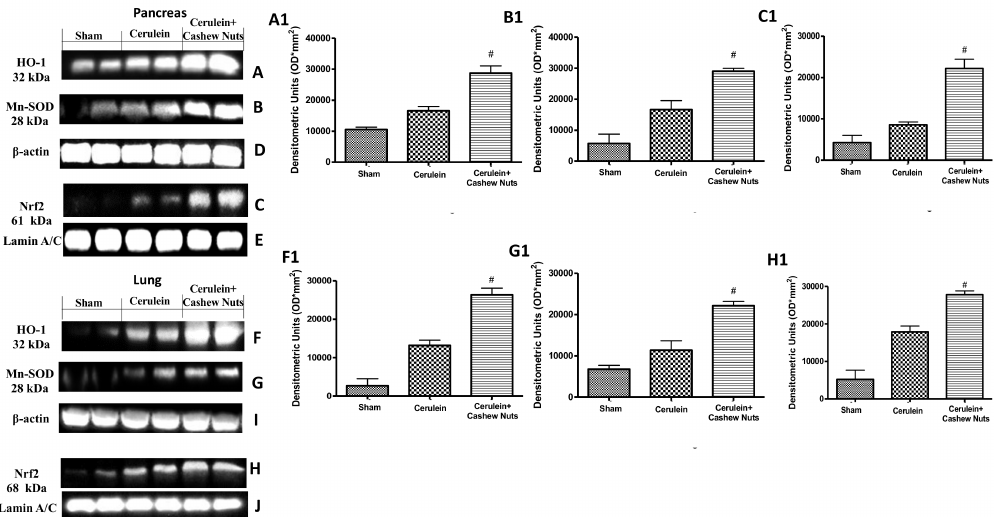
Figure 4. E ff ects of cashew nuts on the nuclear factor E2-related factor 2 (Nrf2) pathway in cerulein-induced AP as assessed by Western blotting. Pancreatic Western blots of HO-1 ( A ), manganese-dependent superoxide dismutase (Mn-SOD) ( B ), nuclear Nrf2 ( C ), β -actin ( D ) and Lamin A / C ( E ). Relative densitometric quantification of pancreatic HO-1 (A1), Mn-SOD (B1) and nuclear Nrf2 (C1). Lung Western blots of HO-1 ( F ), Mn-SOD ( G ), Nrf2 ( H ), β -actin ( I ) and Lamin A / C ( J ). Relative densitometric quantification of lung HO-1 (F1), Mn-SOD (G1 and nuclear Nrf2 (H1). Western blots shown are representative of at least 3 independent experiments. Values shown are means ± SEM of 6 mice. # p < 0.05 vs.